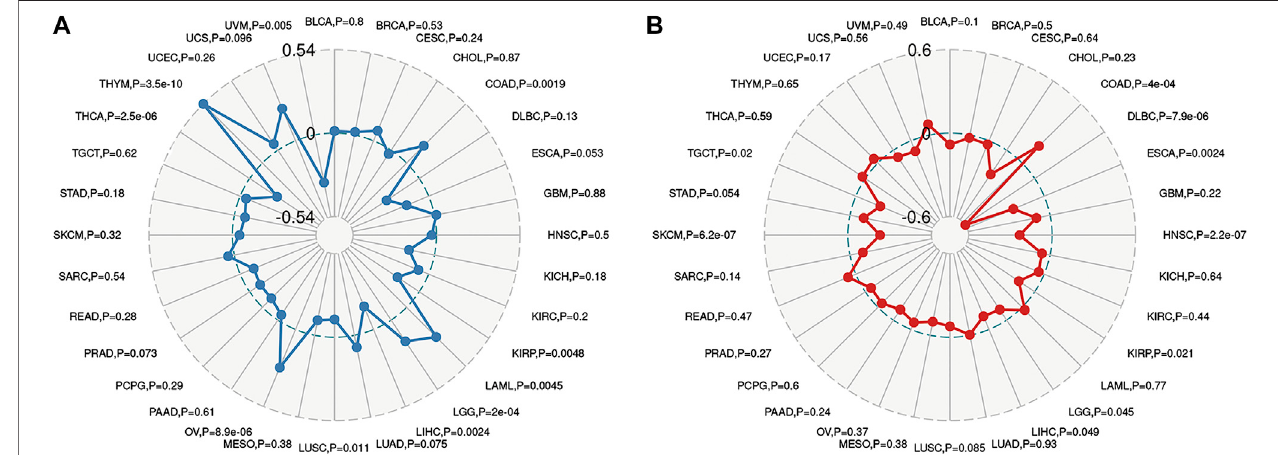
Frontiers in Pharmacology |